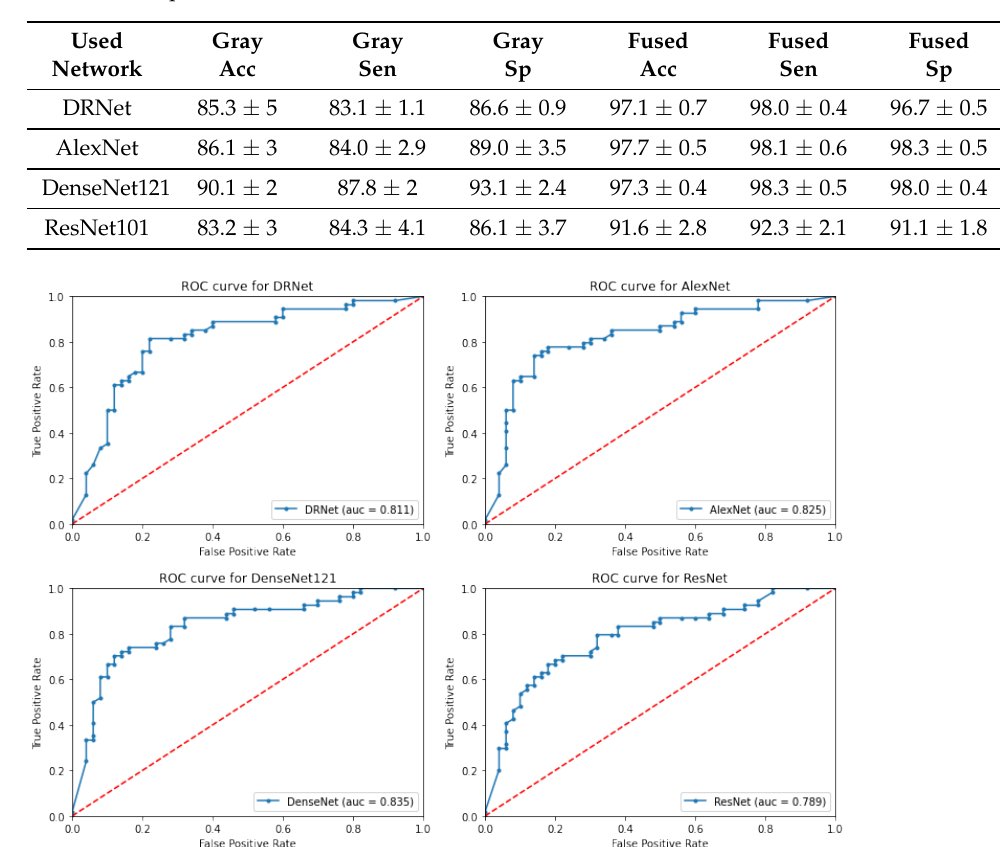
Table 2. LOSO accuracy, sensitivity, and specificity comparisons for both graylevel and fused images (all values are percentiles).